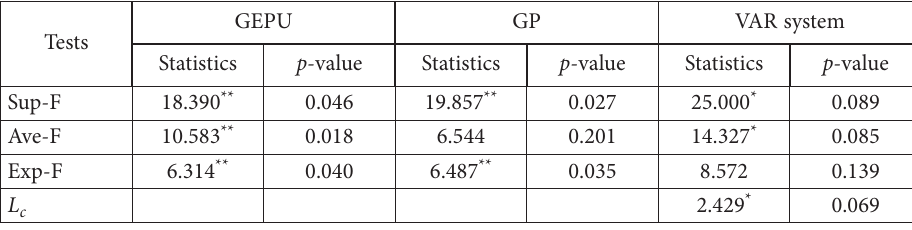
Table 3. The results of parameter stability